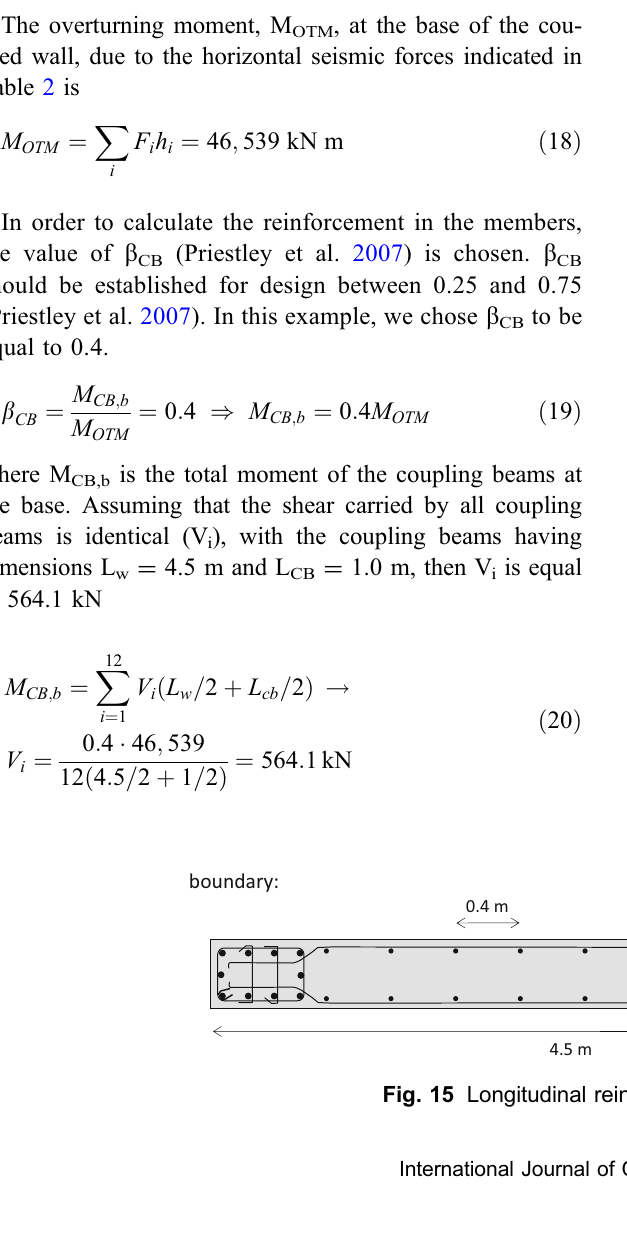
Fig. 14 Mechanism analysis.